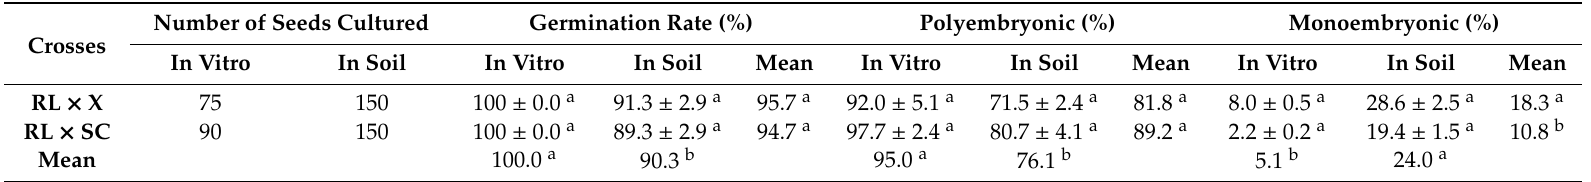
Table 4. Total number of seeds analyzed, germination rates, and percentage of monoembryonic and polyembryonic seeds from two crosses. Number of Seeds Crosses